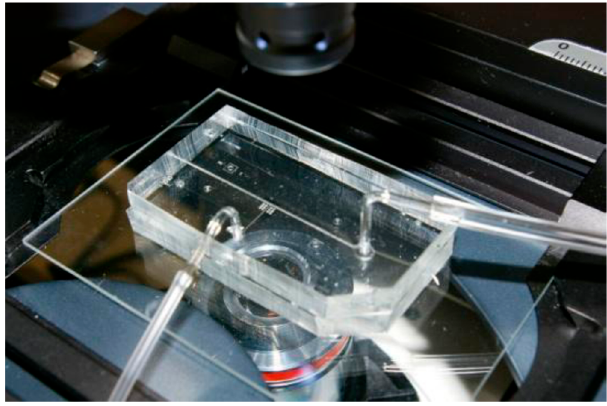
Figure 1. Transparent micro-fluidic chip used for visualization experiments.